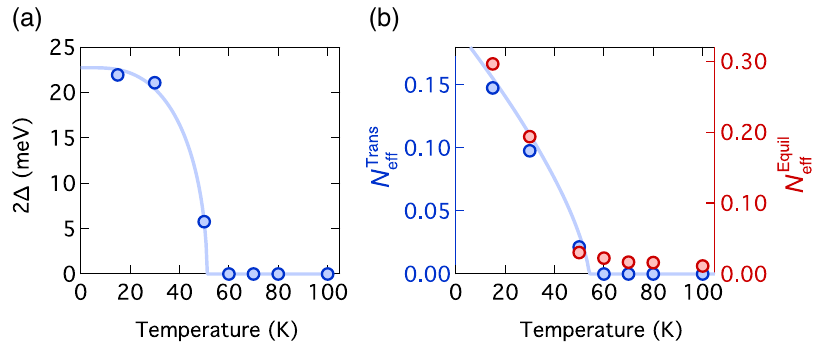
FIG. 4. (a) Photoinduced optical gap 2 Δ , extracted from Mattis-Bardeen fits to the transient optical properties of Fig. 3, as a function of base temperature. (b) Blue, left scale: Temperature dependence of the effective number of “ condensed ” carriers per unit cell in the transient state, N Trans . Red, right scale: Corresponding effective number of mobile carriers per unit cell in the equilibrium metallic state eff before photoexcitation, N Equil (see discussion in the text). These data have been taken upon vibrational excitation with a pump fluence of eff 2 mJ = cm 2